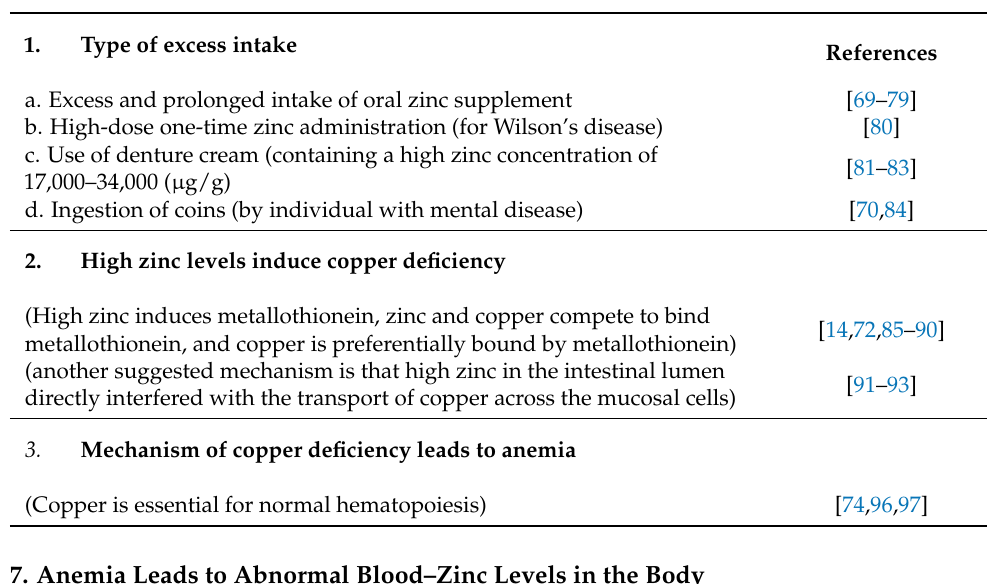
Table 2. Excess intake of zinc leads to